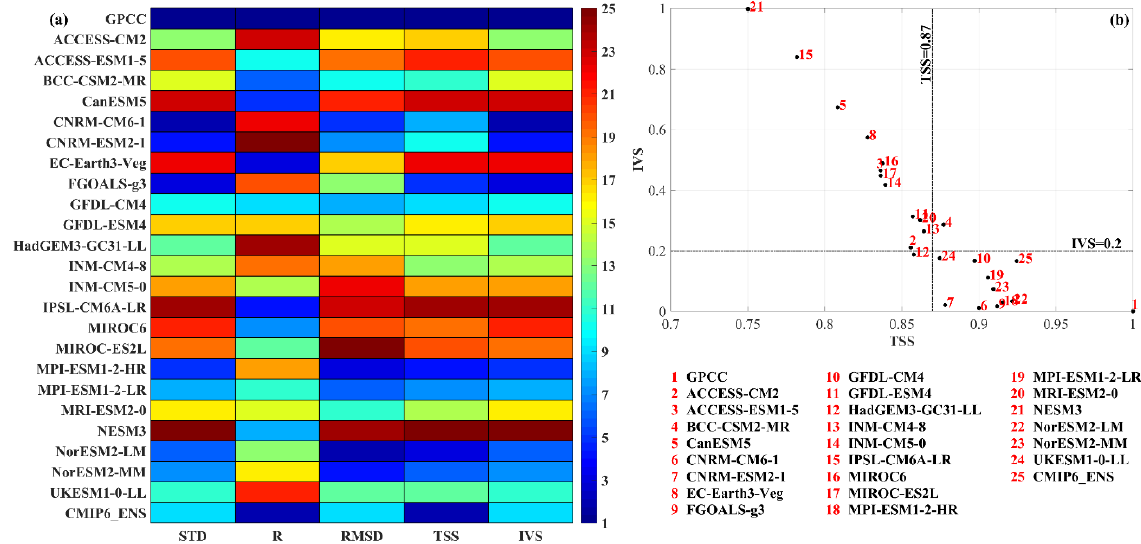
Figure 7. CMIP6 GCM ranking based on precipitation data from 1901 to 2014. ( a ) Portrait diagram displaying the ranks of the different datasets for standard deviation (STD), correlation (R), root-mean-square difference (RMSD), Taylor skill score (TSS) and inter-annual variability score (IVS). The blue (red) colors are higher (lower) ranks. ( b ) Scatter plot of TSS against IVS. Each dot is a dataset with an identification number. Datasets in the lower right corner have good performance.